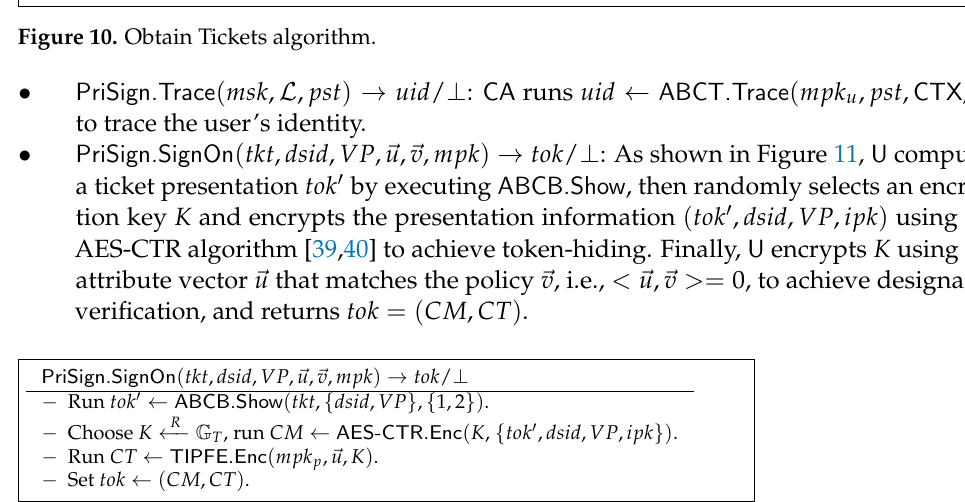
Figure 11. Sign-On